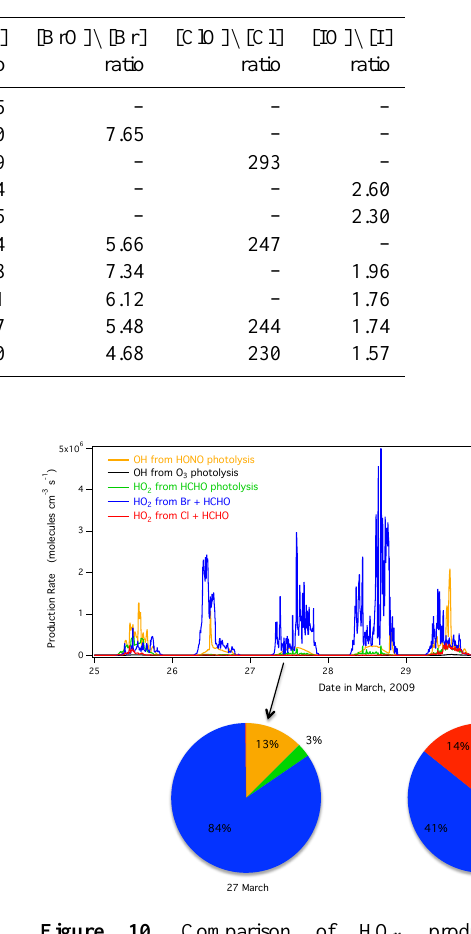
Table 10. Partitioning of the HO x , BrO x , ClO x , and IO x radical partners for mid-day of 29 March for a variety of modeling scenarios performed by including or excluding different halogen species.